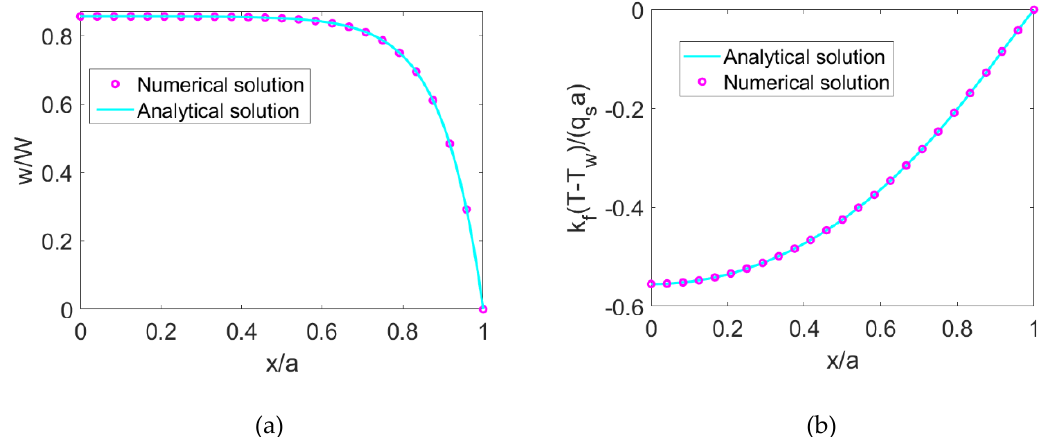
Figure 2. The comparison between the numerical solution and analytical solution from for ( a ) velocity distribution at y = 0 and ( b ) temperature distribution at y =